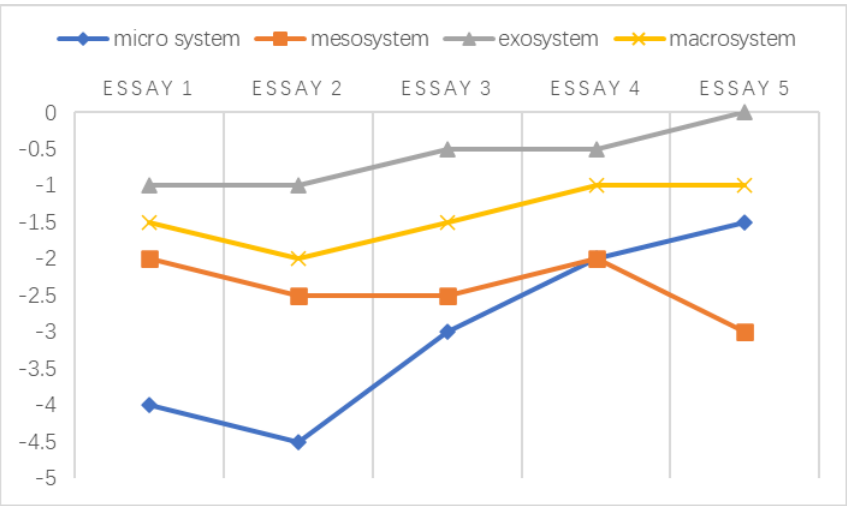
Figure 5. An illustration of T5’s emotional changes in the ecological systems after grading five essays.